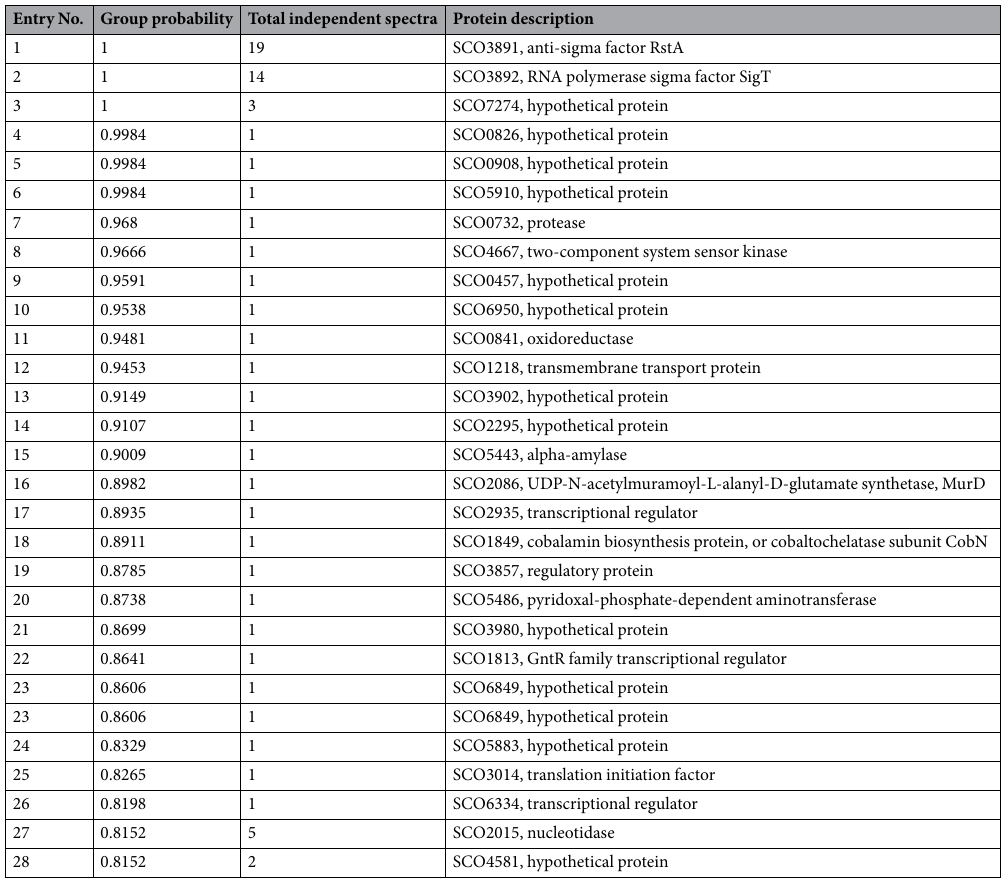
Table 1. Protein identification by HPLC-MS/MS after tandem affinity purification